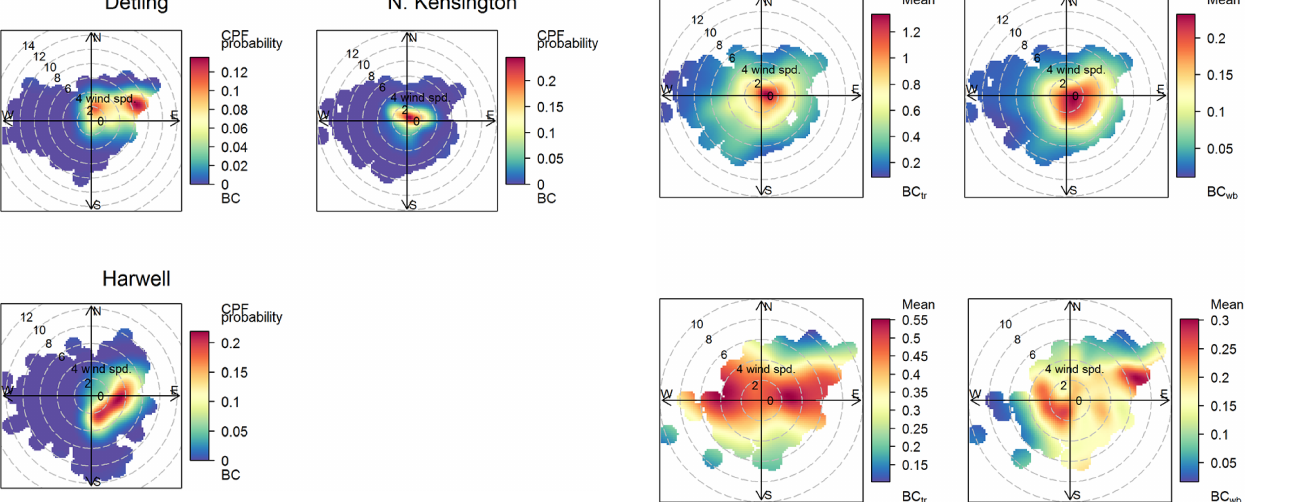
Figure 9. Polar plots of the mean concentration (µgm − 3 ) of BC from traffic (BC tr ) and wood burning (BC wb ) calculated by the two- component aethalometer model at North Kensington (top row) and Detling (bottom row) for the winter campaign. Wind speed is in ms − 1